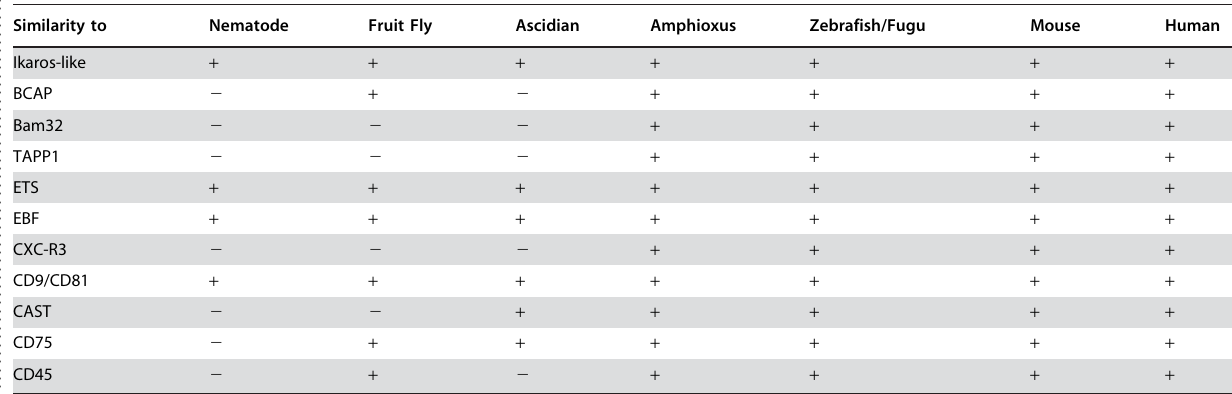
Table 1. Comparative analyses of some lymphoid-related genes in our database in different organisms .. ... .... ... ... .... ... ... .... ... ... .... ... ... .... ... ... .... ... ... .... ... ... .... ... ... .... ... ... .... ... ... .... ... ... .... ... ... .... ... ... .... ... ... . Similarity